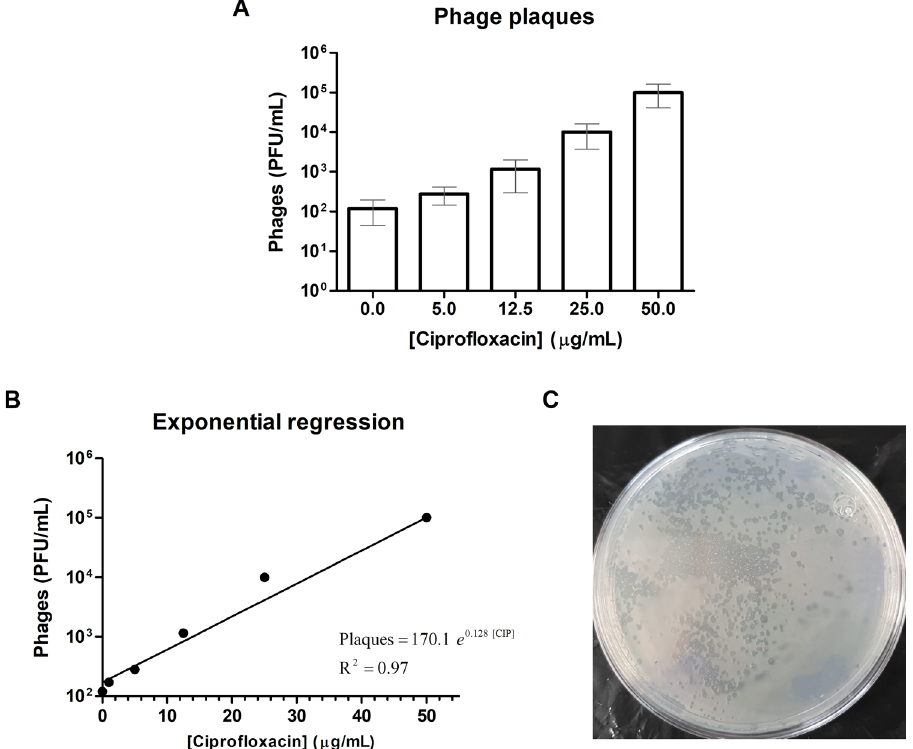
Figure 8. Phage plaques assay of PaeAG1 after exposure to ciprofloxacin. ( A ) Phages of PaeAG1 are induced under CIP exposure, with a pattern of higher induction of phage plaques at higher concentration of the drug, evidenced with an exponential regression as shown in ( B ). ( C ) Example of visualization of phage plaques on culture plate during in vitro